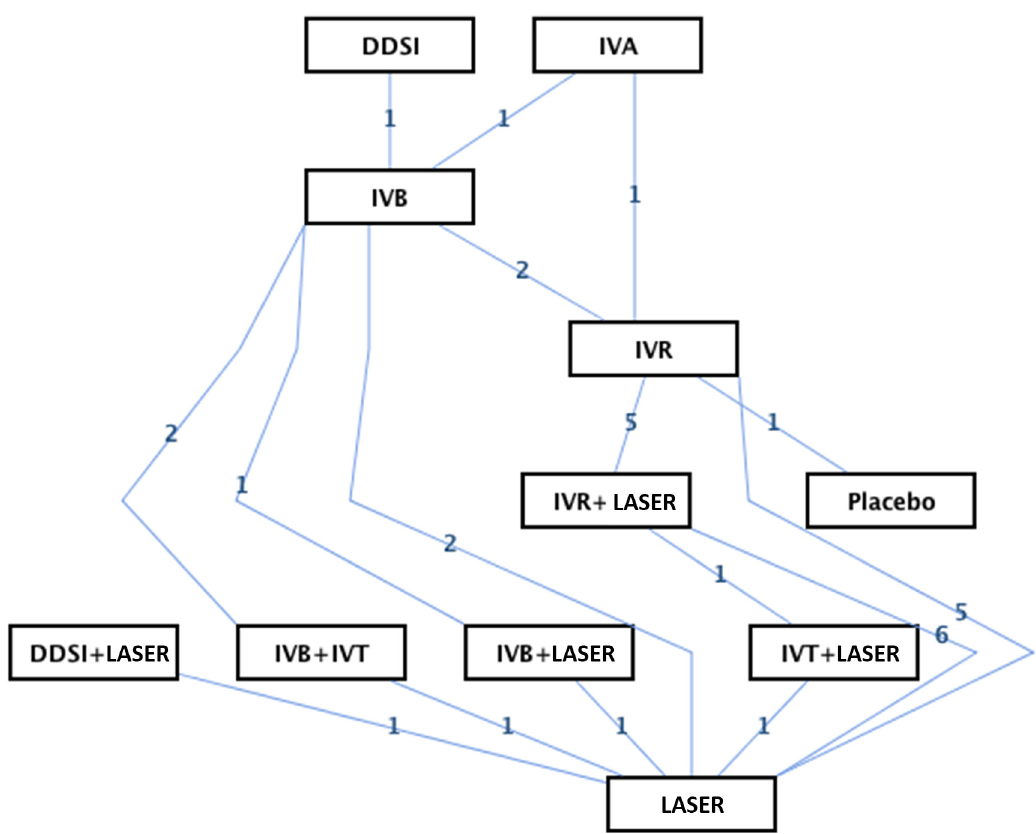
Fig 2. Network of eligible comparisons for the